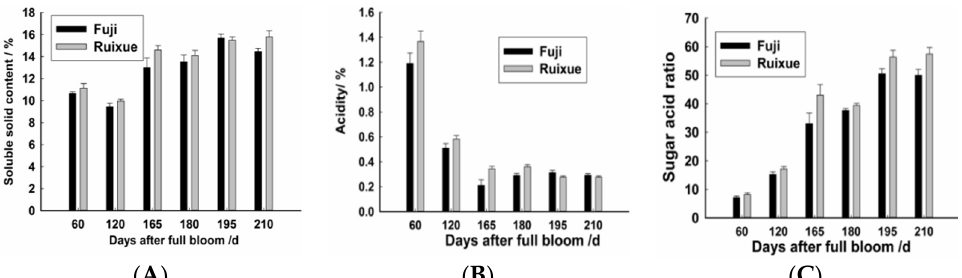
Figure 1. Quality parameters of “Ruixue” and “Fuji” apples during different stages of fruit devel- opment. ( A ) Soluble solid content; ( B ) Acidity; and ( C ) Sugar-acid ratio. Values are means ± stand- ard error of three experimental replicates.